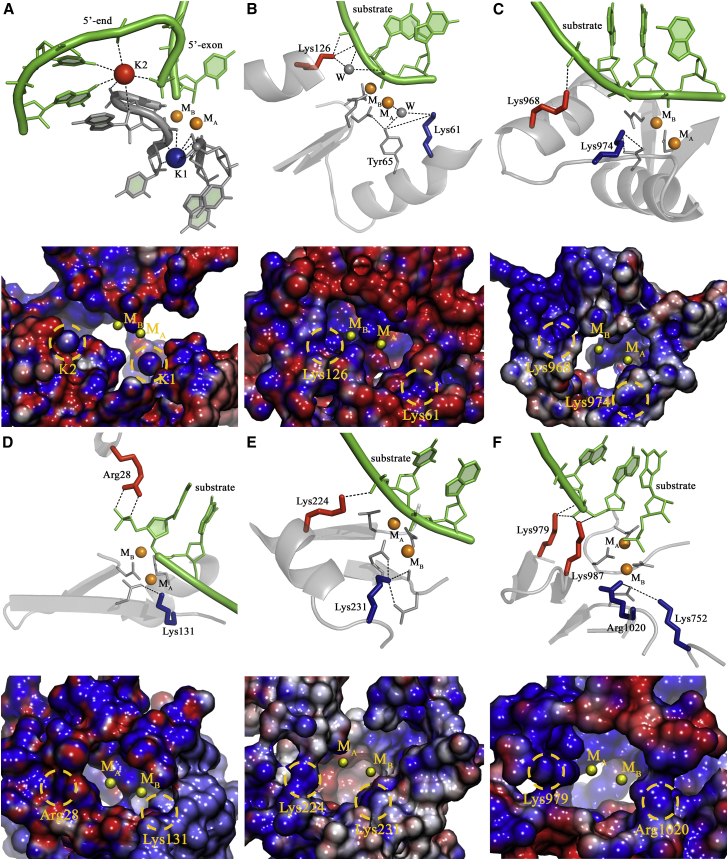
Structural Comparison of the Catalytic Sites of Representative Two-Metal-Ion Enzymes(A) Group II intron (PDB: 4FAR).(B) Restriction endonuclease BamHI (PDB: 2BAM).(C) SpyCas9 (RuvC active site modeled from PDB: 4CMQ and 5F9R).(D) Exonuclease Exo-λ (modeled from PDB: 4WUZ and 3SM4).(E) DNA polymerase Pol-η (PDB: 4ECS).(F) RNA polymerase Pol-II (PDB: 2E2H, predicted from medium-resolution structures, see Table S2).Each top panel presents the structure of the active site of the respective molecules in ribbon-stick representation. End each bottom panel presents the molecular surface surrounding the two-metal-ion active sites (radii 15 Å) colored by intensity of electrostatic potential (−10 kT/[darkest red] to +10 kT/e [darkest blue]). Catalytic divalent ions (MA-MB) are depicted as orange spheres, substrates are represented in green, and the backbone of the corresponding macromolecule is in gray, with acidic residues coordinating MA-MB represented as sticks. K1- and K2-like elements are depicted as spheres (for ions) or sticks (for amino acids) in blue and in red, respectively. “W” indicates water molecules. Black dashed lines indicate ionic or hydrogen-bond interactions established by K1-and K2-like elements with active site residues and reactants. K1-like elements rigidify the residues that coordinate MA-MB, while K2-like elements orient the substrates into the active site. All structures have been drawn using PyMOL.